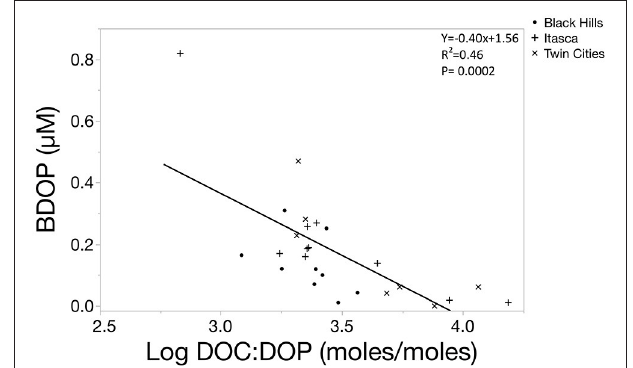
FIGURE 8 | Scatterplot showing the linear regression function comparing the concentration of BDOP to the DOC:DOP ratio of the initial sample (log transformed). The significant negative relationship demonstrates BDOP is drawn down as DOP becomes scarce relative to DOC.